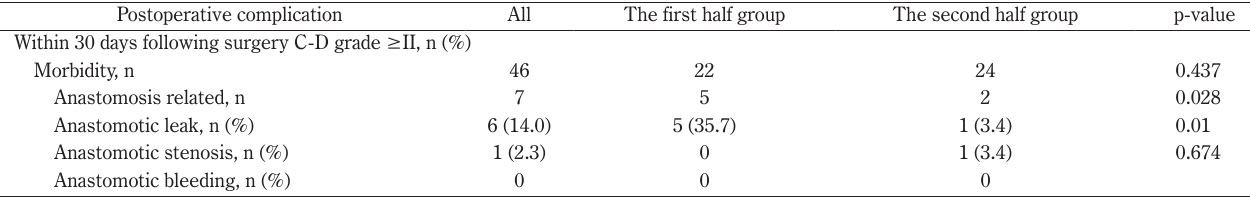
Table 3 Postoperative complications of thoraco-laparoscopic